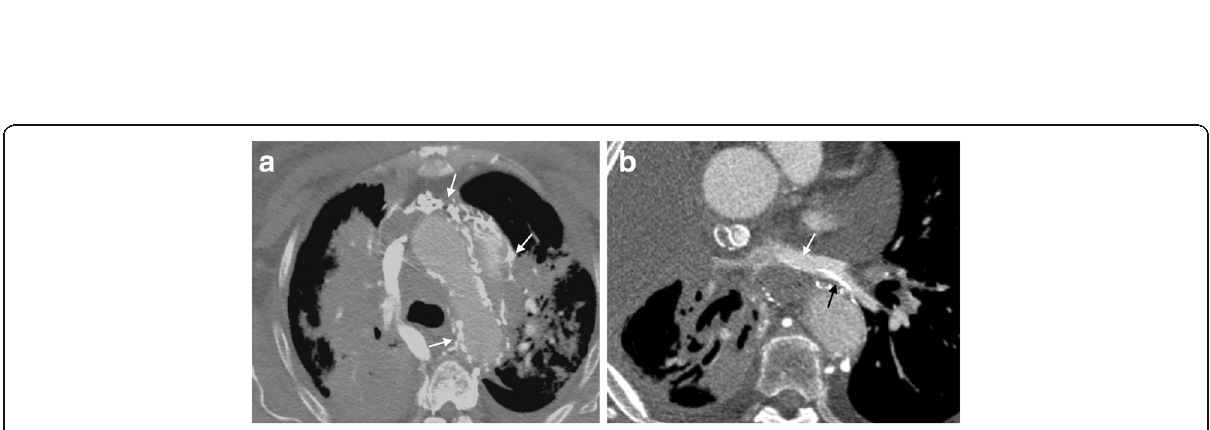
Fig. 12 Unusual collaterals. a Axial CT image of a patient with numerous unnamed collateral vessels coursing through the mediastinum (white arrows). b Axial CT scan demonstrates collateral vessels (black arrow) draining into the left pulmonary veins (white